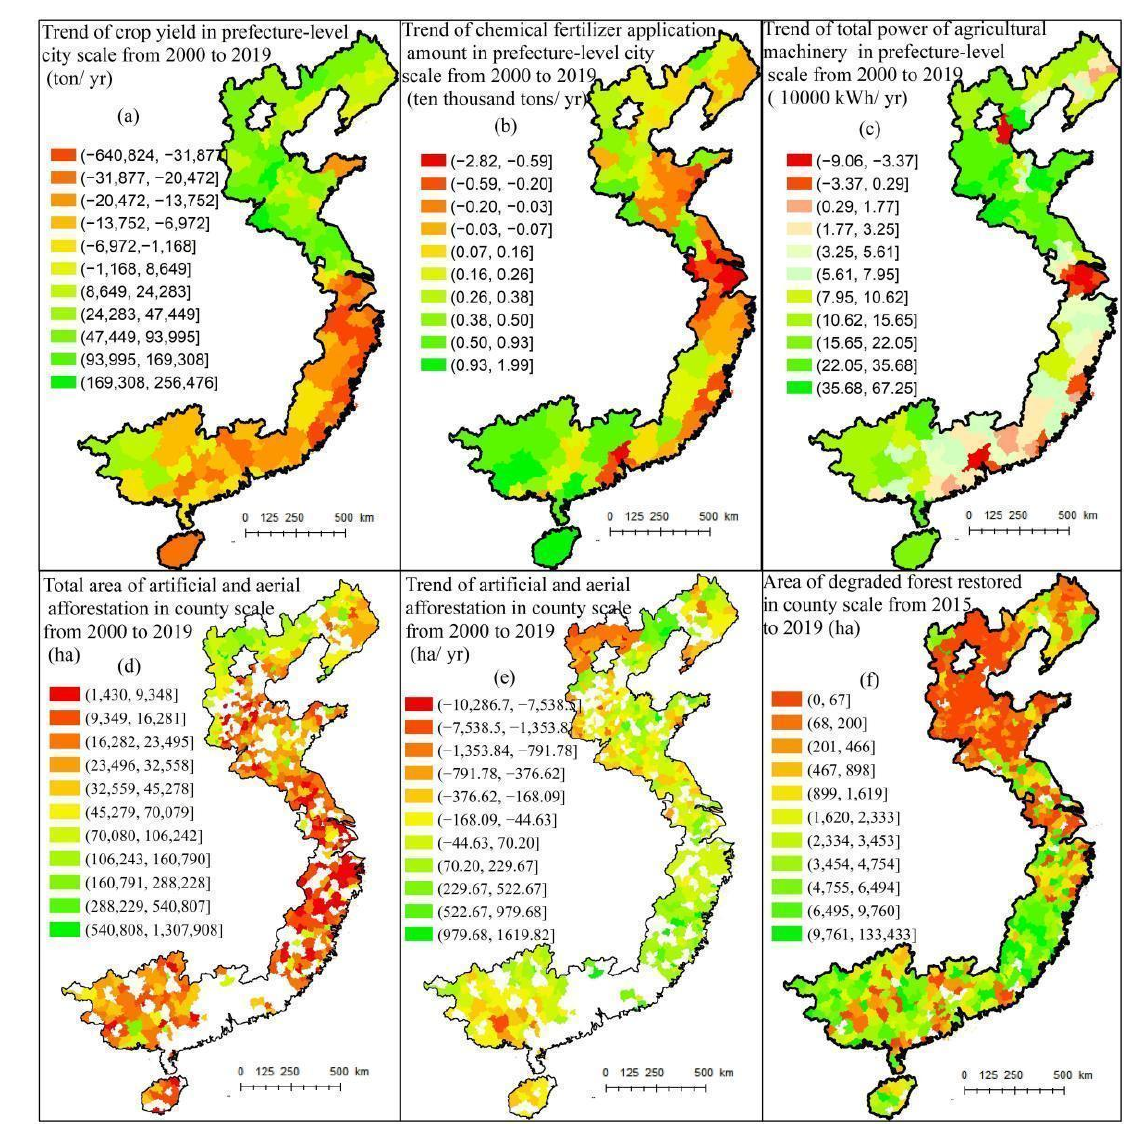
Figure 6. Crop yield and afforestation